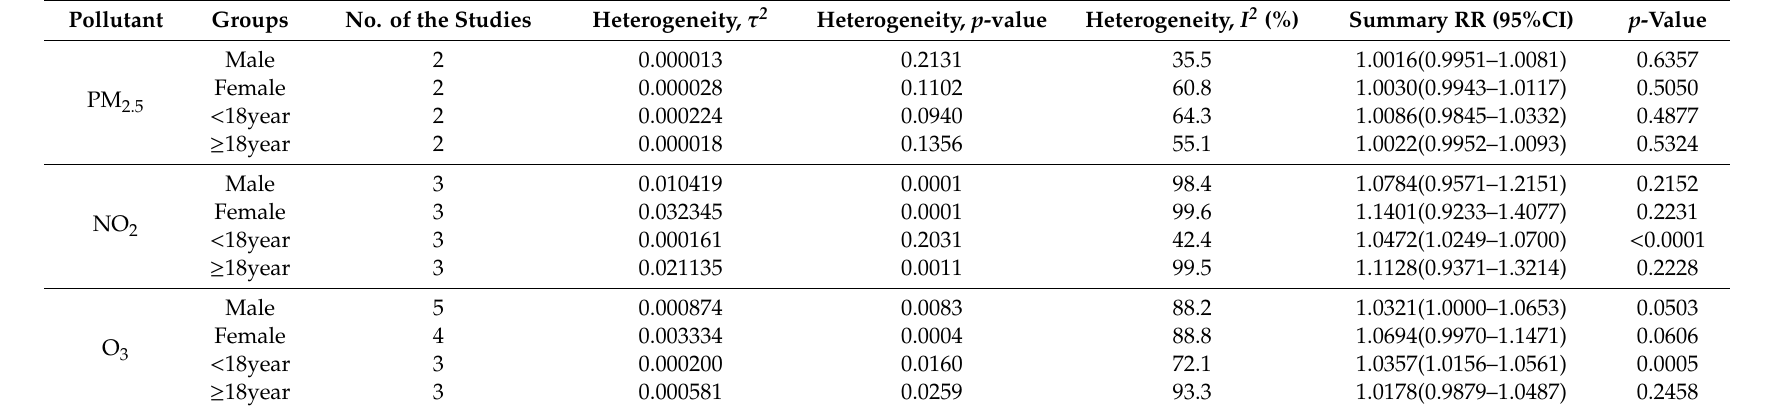
Table 2. Risk analysis of air pollutants on patients with conjunctivitis, stratified by gender and age